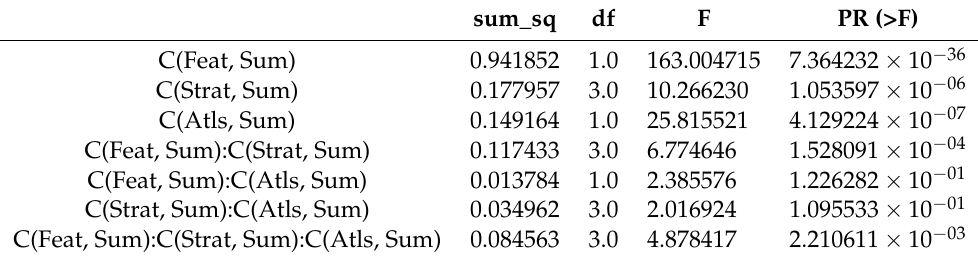
Table 2. Multifactorial (3-way) ANOVA results. Feat denotes feature representation, Atls denotes the used atlas, and Strat is one of the four preprocessing strategies. sum_sq, df, F, PR are standard result names of sum of squares, degree of freedom, F_score, and p _value of this F_score, for each factor.